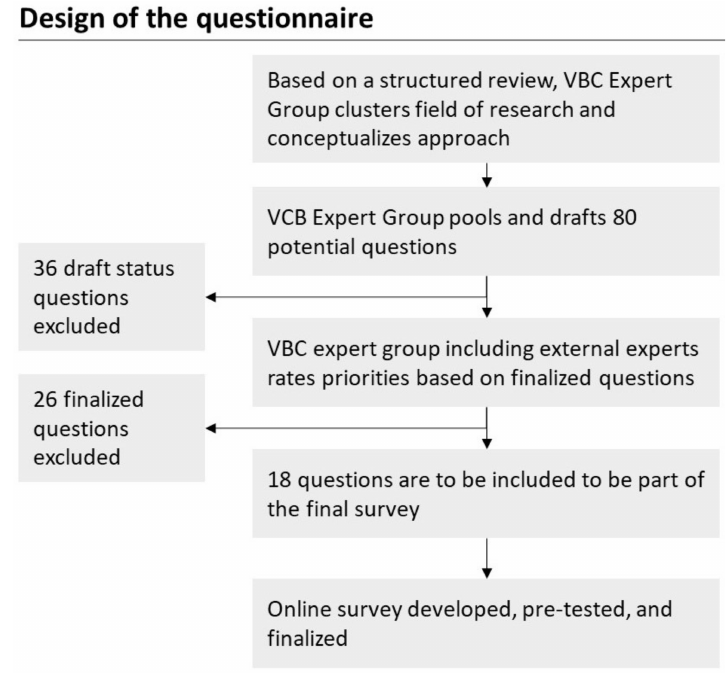
Figure 1. Overall study